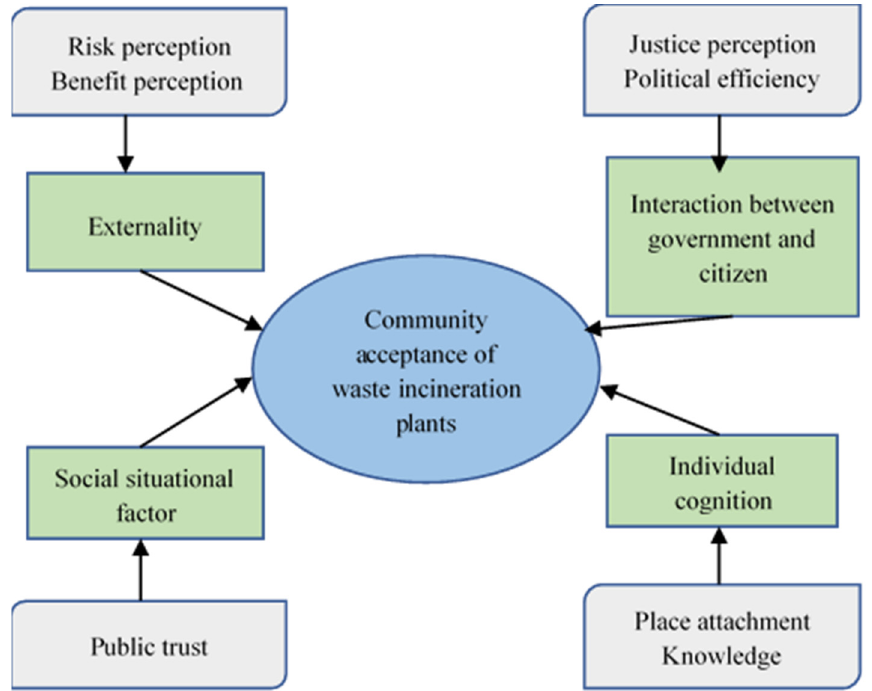
Figure 2. Theoretical framework of community acceptance of waste incineration plants.